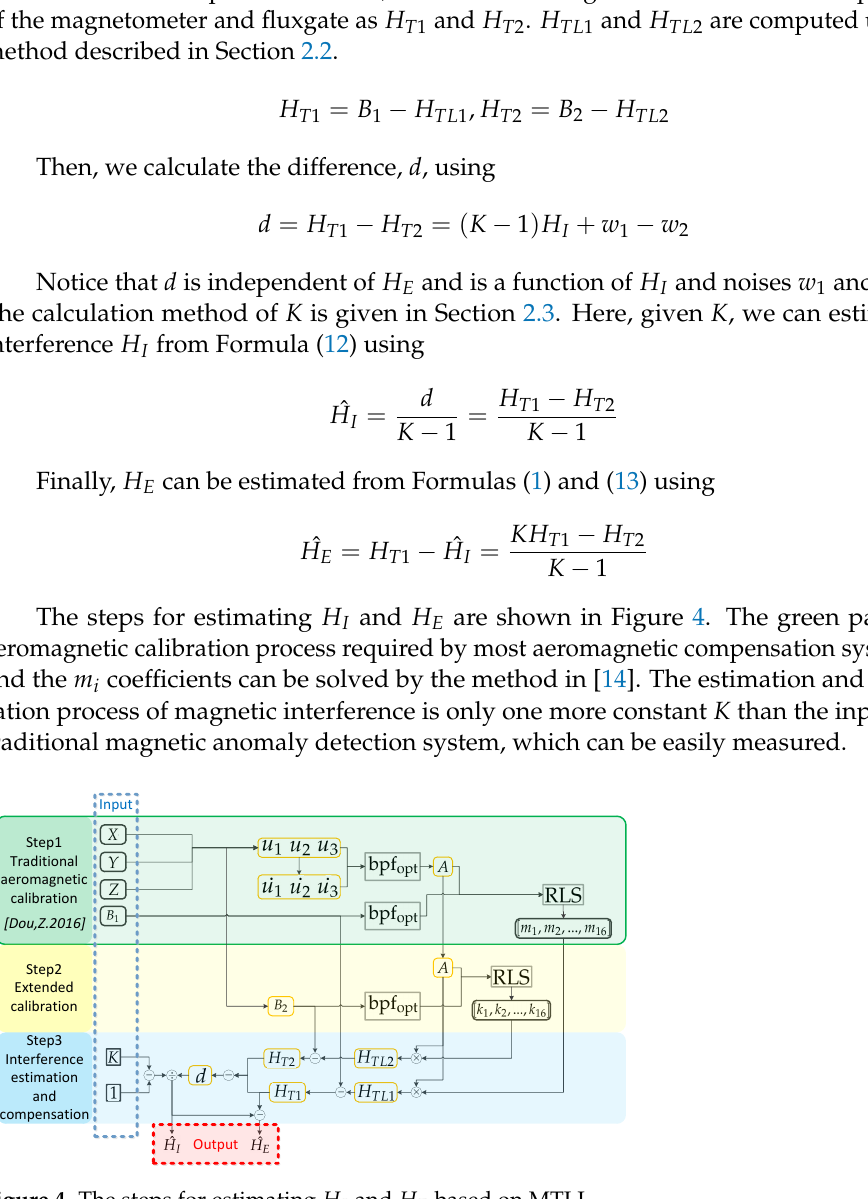
Figure 4. The steps for estimating H I and H E based on